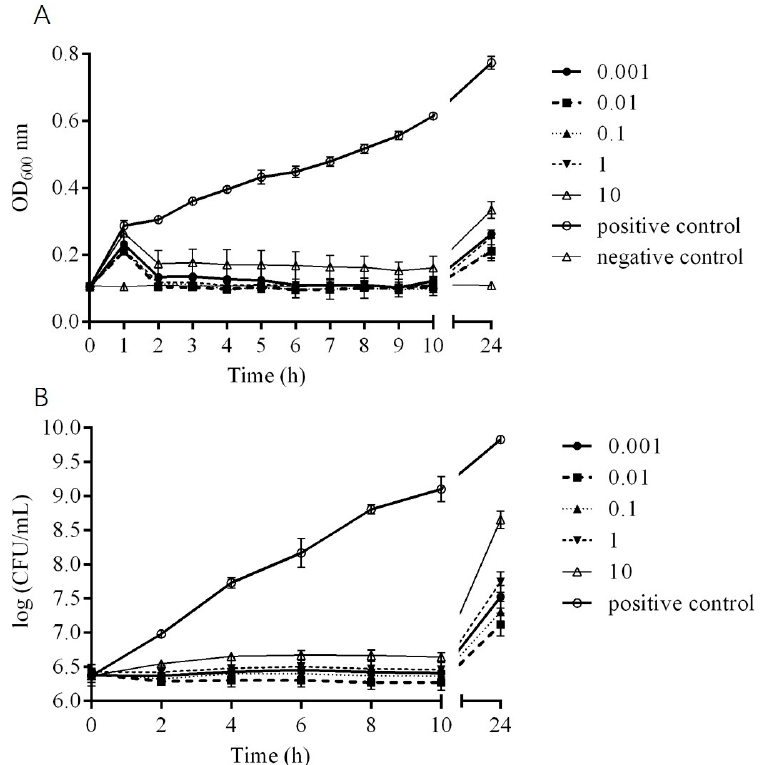
Figure 4. In vitro bactericidal activity of phage DCp1. ( A ) In vitro bactericidal activity of phage DCp1 against C. perfringens D22 strain at different MOIs (10, 1, 0.1, 0.01, and 0.001). ( B ) CFUs of phage DCp1 against C. perfringens D22 at different MOIs (10, 1, 0.1, 0.01, and 0.001). The data are expressed as means ± SD (n = 3).